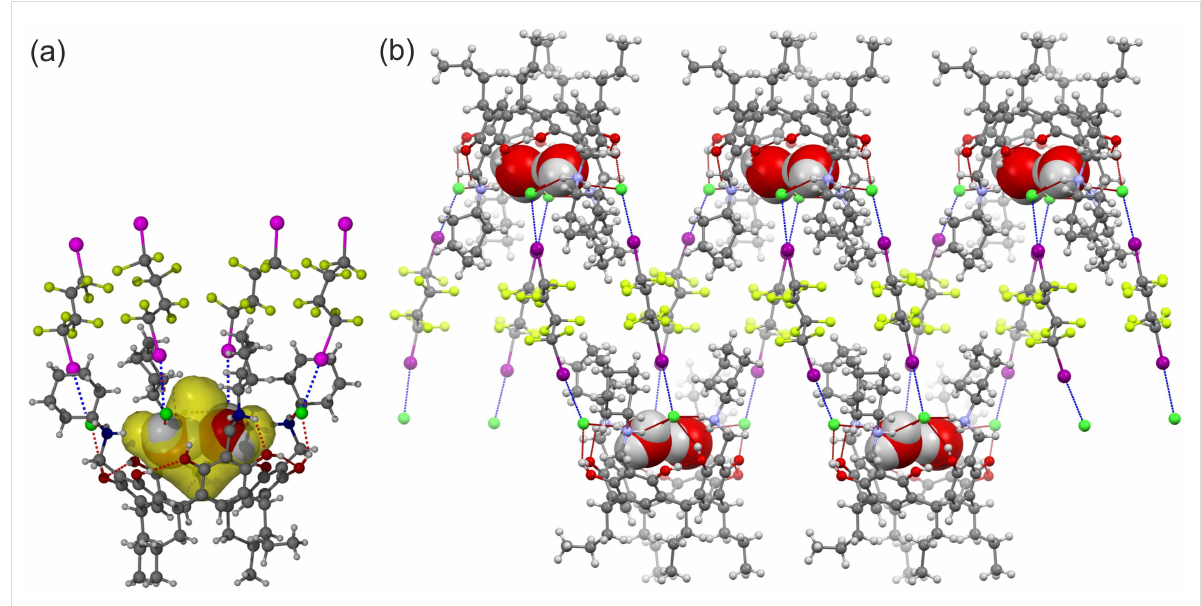
Figure 4: (a) The halogen bonding (blue broken lines), hydrogen bonding (red broken lines) and the host–guest effect (water molecules in CPK, and the cavity space in transparent yellow cloud) in Water@ 2 &DIOFB; (b) The halogen bonded polymer. Water molecules in CPK mode and all the other in ball-and-stick type.